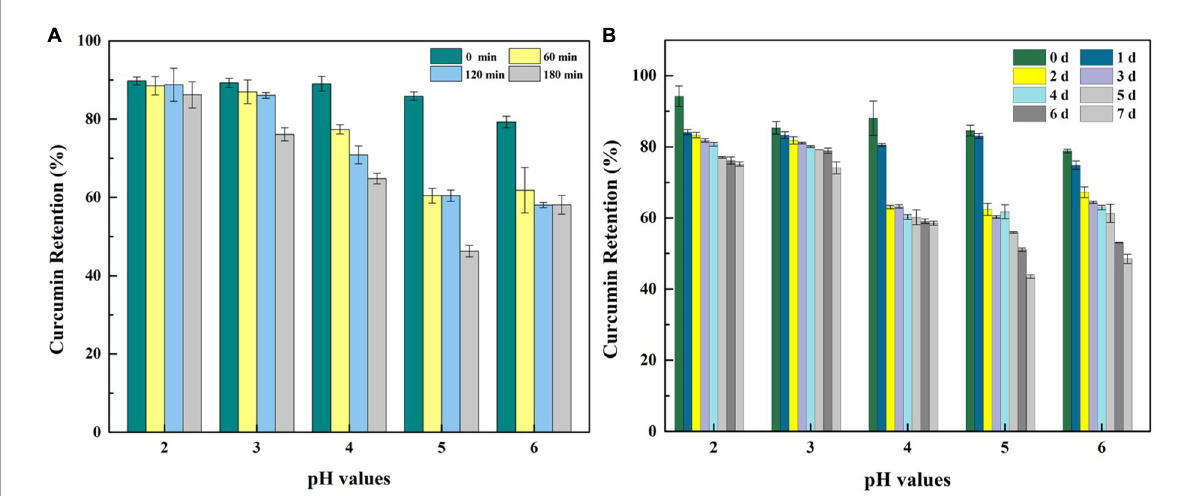
FIGURE7 Curcumin retention of WPF-GNP-C hydrogel (4:1) after heated at 85 ◦ C for 3 h (A) and after ultraviolet radiation for 7 days (B) at various pH values in the absence of